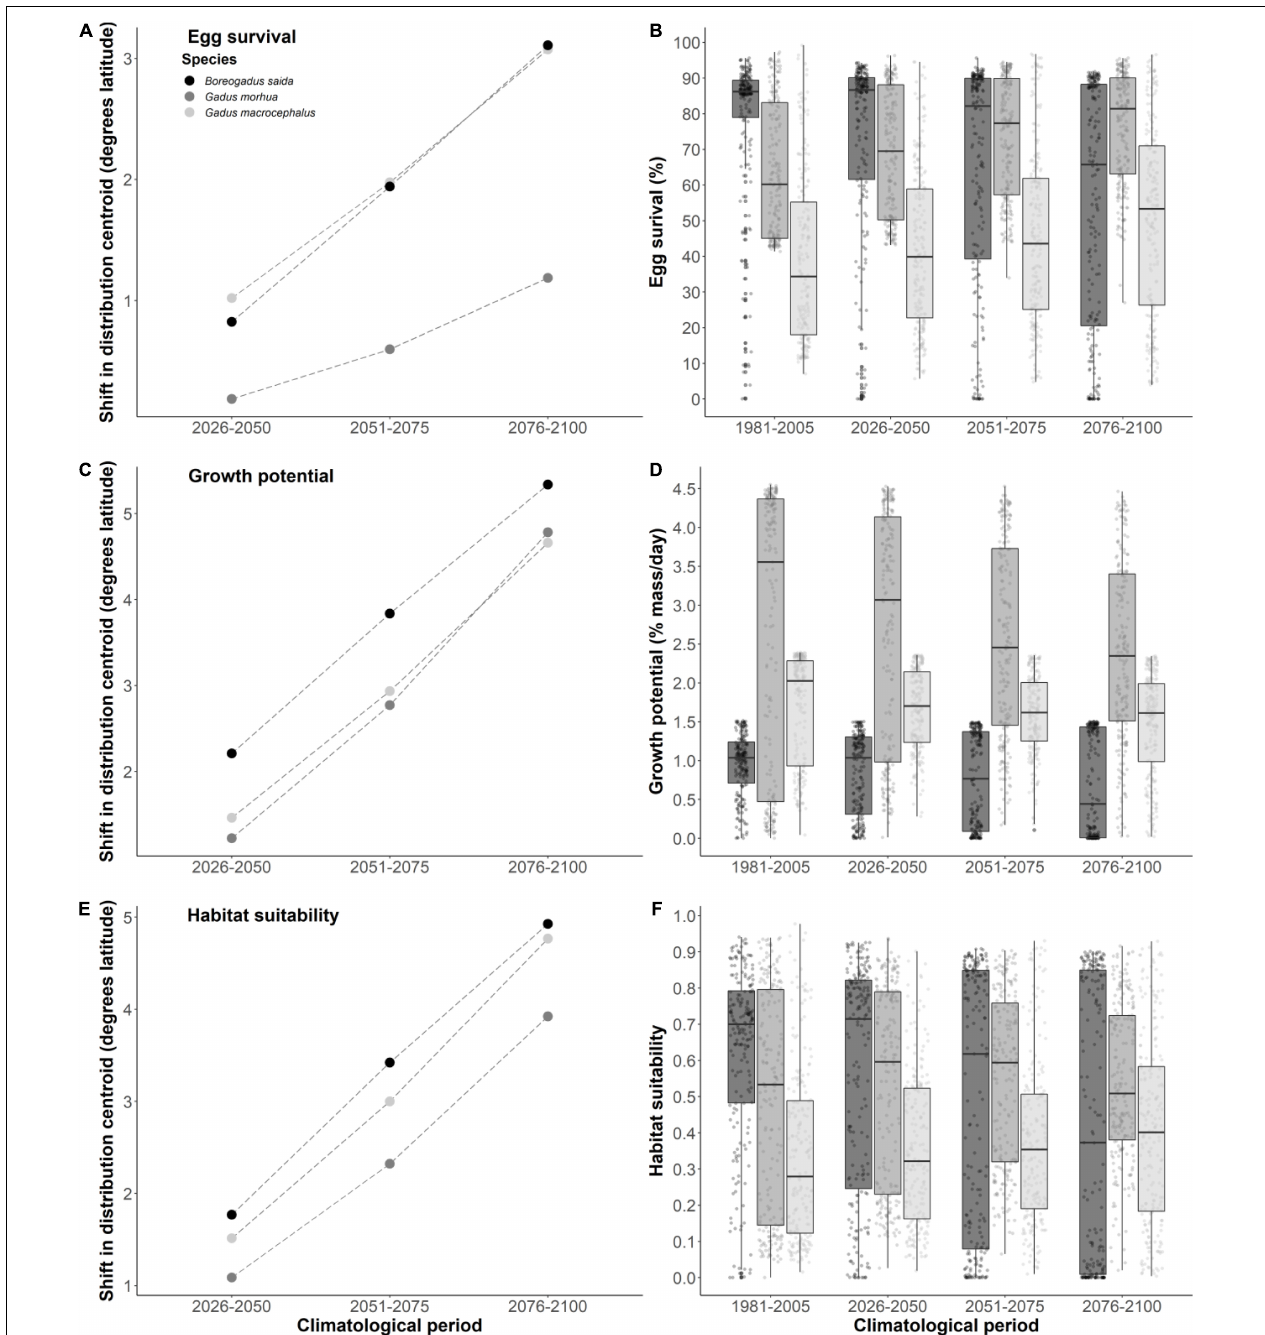
FIGURE 1 | Shift in the distribution centroid between the historical baseline period (1981–2005) and each future climatology period for egg survival (A) , juvenile growth potential (C) , and thermal habitat suitability index (E) for Polar cod, Atlantic cod, and Greenland cod. For each development metric, the distribution of individual raster cell values across the historic baseline period and future simulated periods are plotted (individual points; B,D,F ) and summarized with boxplots showing the 25th, 50th, and 75th percentiles of plotted values for each species. Tails on boxplots represent 1.5 times the interquartile